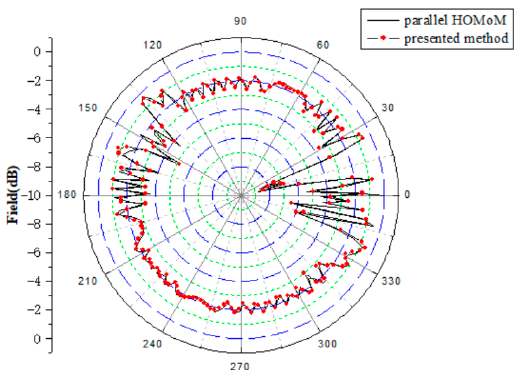
Figure 10. Disturbed pattern on xoz plane calculated by feeding each unit in turn.